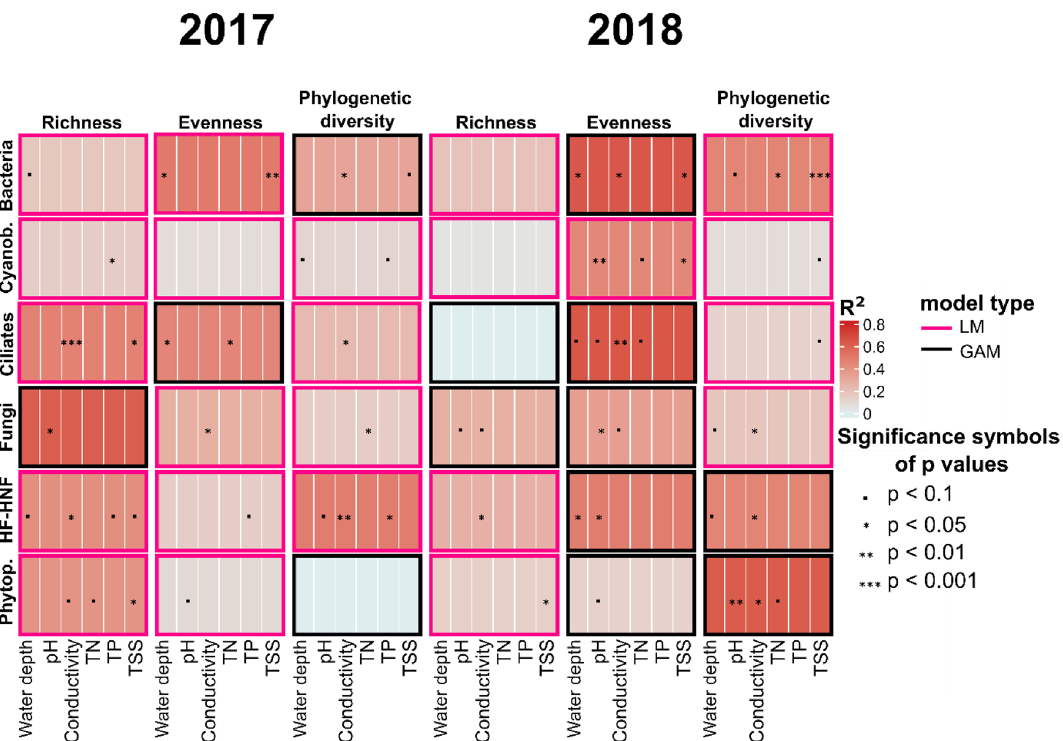
Figure 6. Heatmap of the best-fit models with the significant environmental variables for the six major taxonomic groups (in rows) and their local diversity indices (richness, evenness, phylogenetic diversity) in the two sampling years (in columns). One model is represented by one box, where the shading indicates the overall R 2 of each multiple regression model (either linear or GAM-based, indicated by the colour of the frame of each box), while the significance symbols belong to individual predictors in the final model. Abbreviation of the group names: Cyanob. = Cyanobacteria, Phytop. = Phytoplankton, HF-HNF = Heterotrophic flagellates and